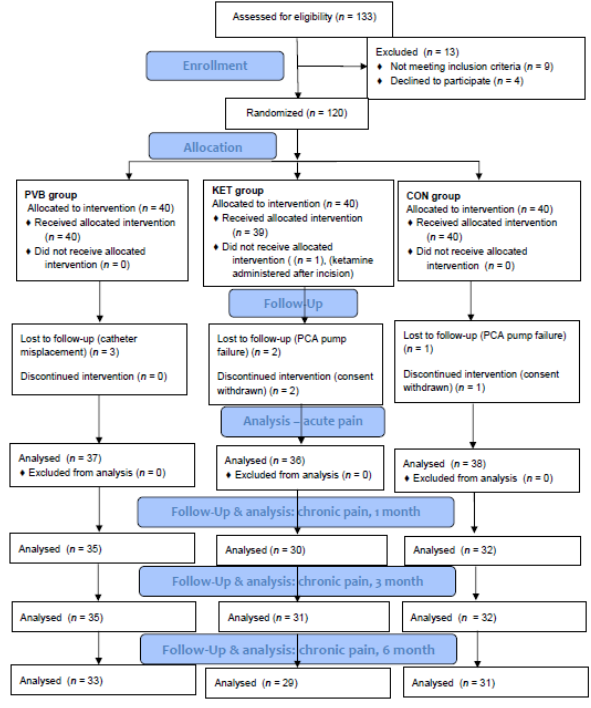
Figure 1. Study flowchart. CON denotes control group, KET denotes ketamine group, PVB denotes paravertebral block group, PCA denotes patient-controlled analgesia.